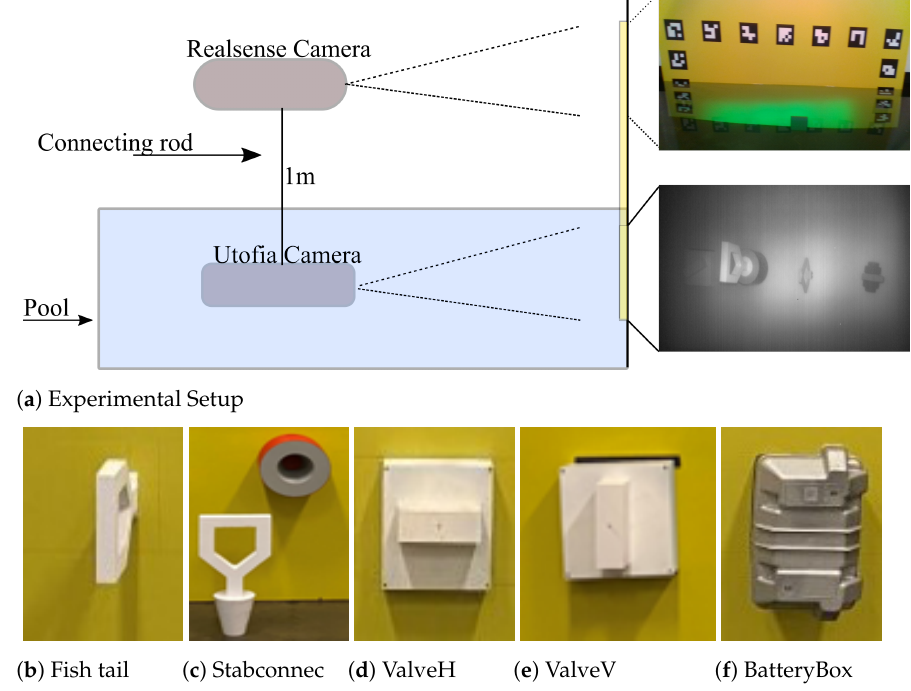
Figure 1. Experimental setup and objects of interest. ( a ) shows capturing setup. Realsense and Utofia cameras are time synced, and the projection between the two cameras is established using known locations of the Aruco markers. ( b – f ) shows typical objects such as valves, fish-tails, stab-connector, and gauges that are common in sub-sea inspection.